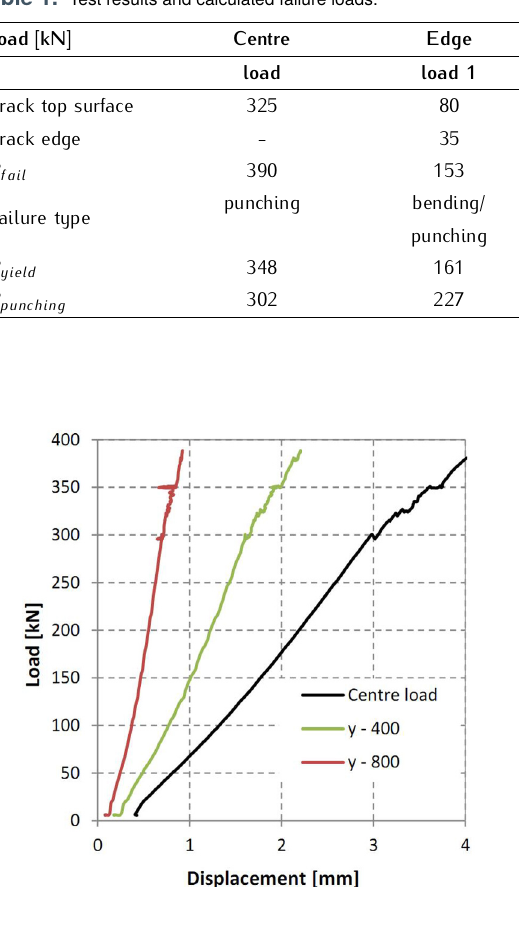
Table 1. Test results and calculated failure loads.